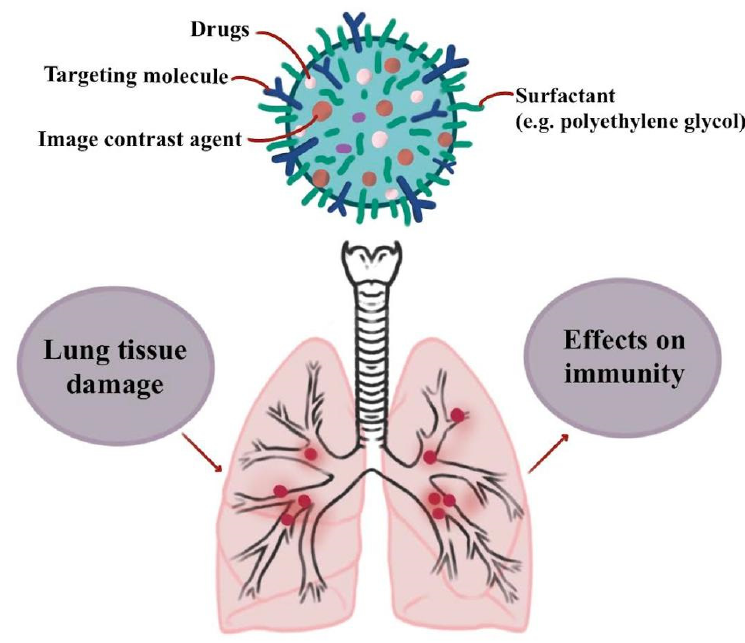
Figure 3. The effects of nanoparticle drugs on immunity. The flow partitions between the left and right lungs, as well as the lower and higher lobes of the left lung, varied tenfold between the most dilated and restricted models, suggesting significant differences. Much lower dosages were anticipated on the surface of the restricted left-lower bronchioles G4–G9, as well as in the peripheral airways beyond G9 of the left-lower lung [47]. Nanocurcumin was studied for its therapeutic effects on the quantity and reactivity of Th17 cells in COVID-19 patients with moderate and severe illness. The study included 40 patients in an intensive care unit who had moderate